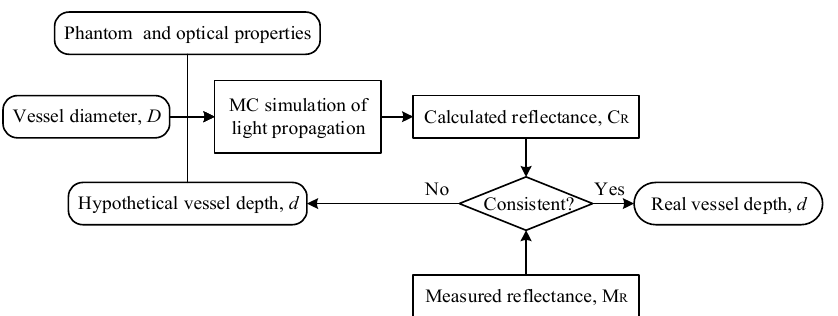
Figure 7. D RS-based inverse method for estimating blood vessel depth in the PWS tissue model.